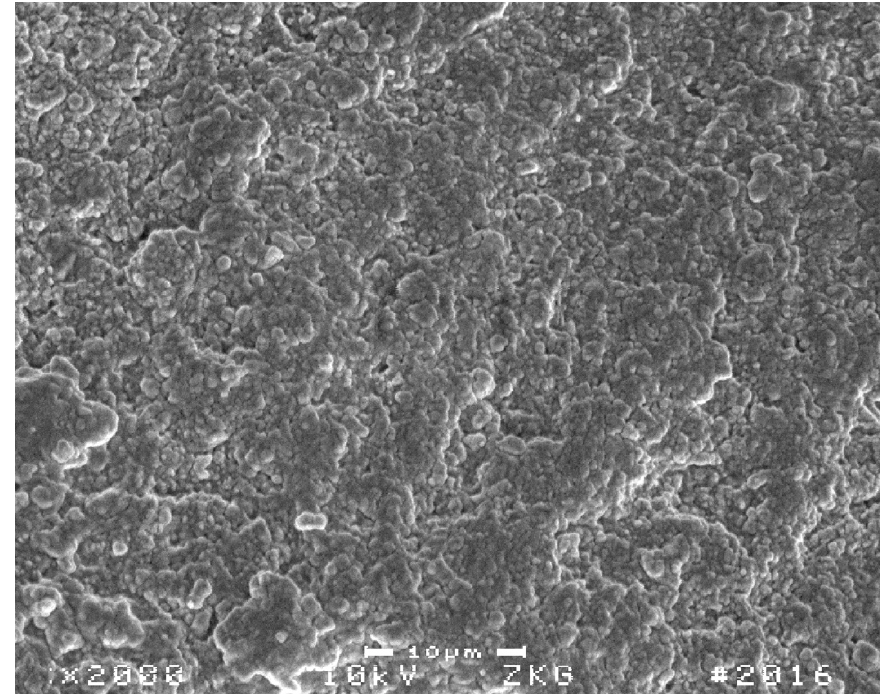
Figure 12. Representative SEM image of a selected TECB fracture surface.